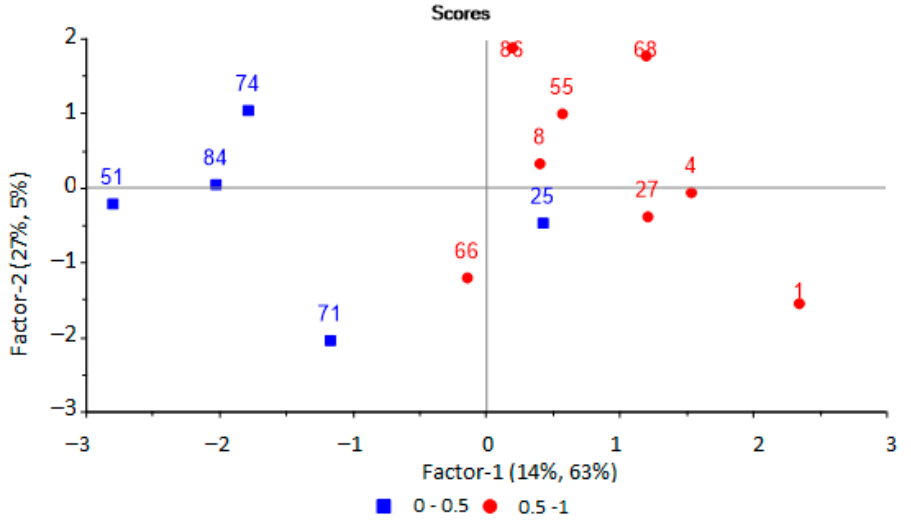
Figure 7. PLS-model scores plot for predicting the presence of microorganisms in biomaterial based on the results of the analysis of EGP of urine samples by an array of sensors.